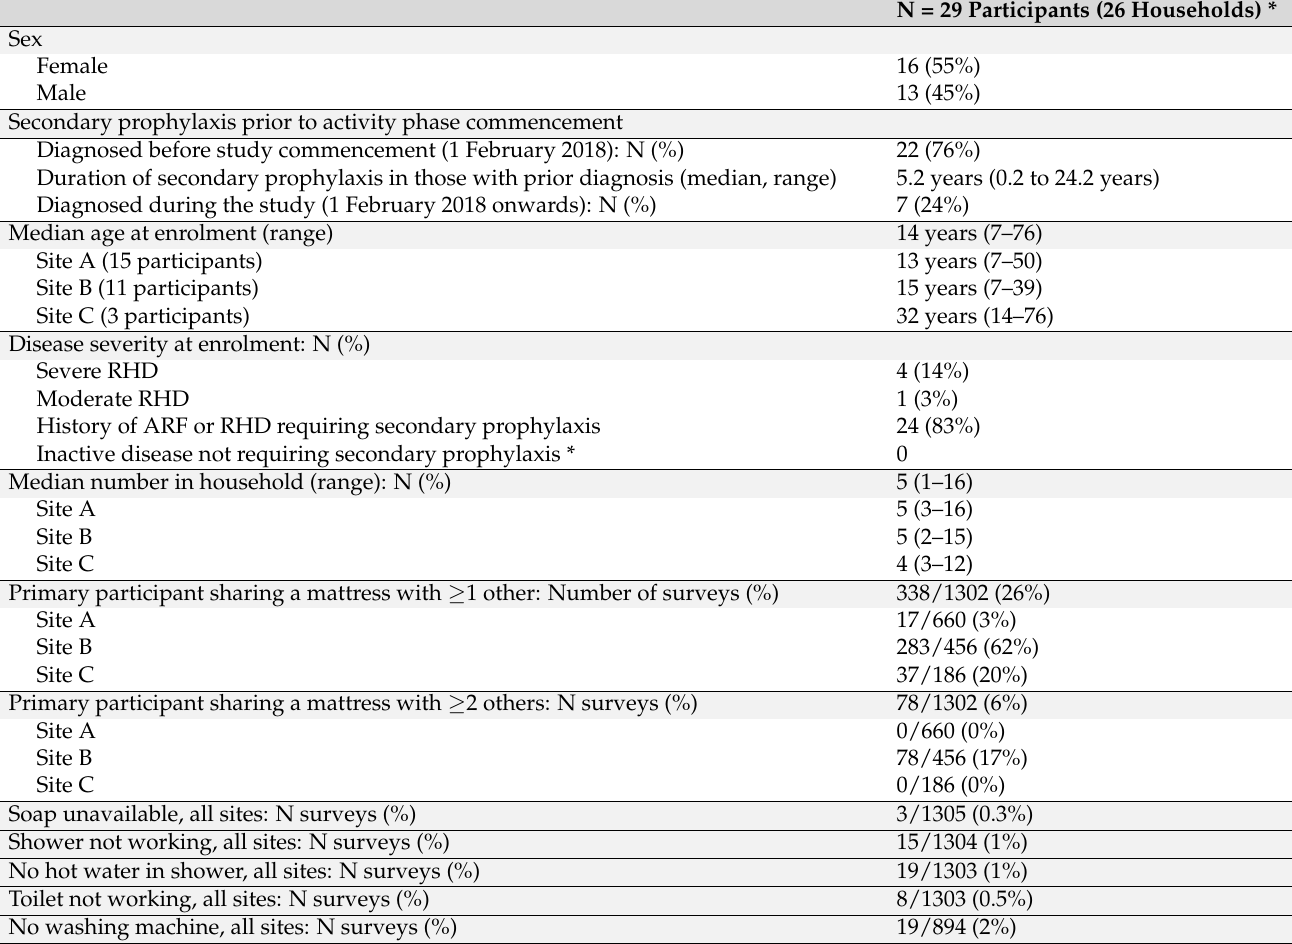
Table 1. Primary participant demographic, clinical and household